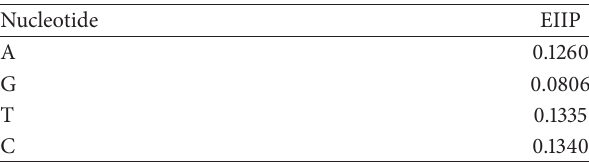
Table 1: EIIP values of nucleotides.